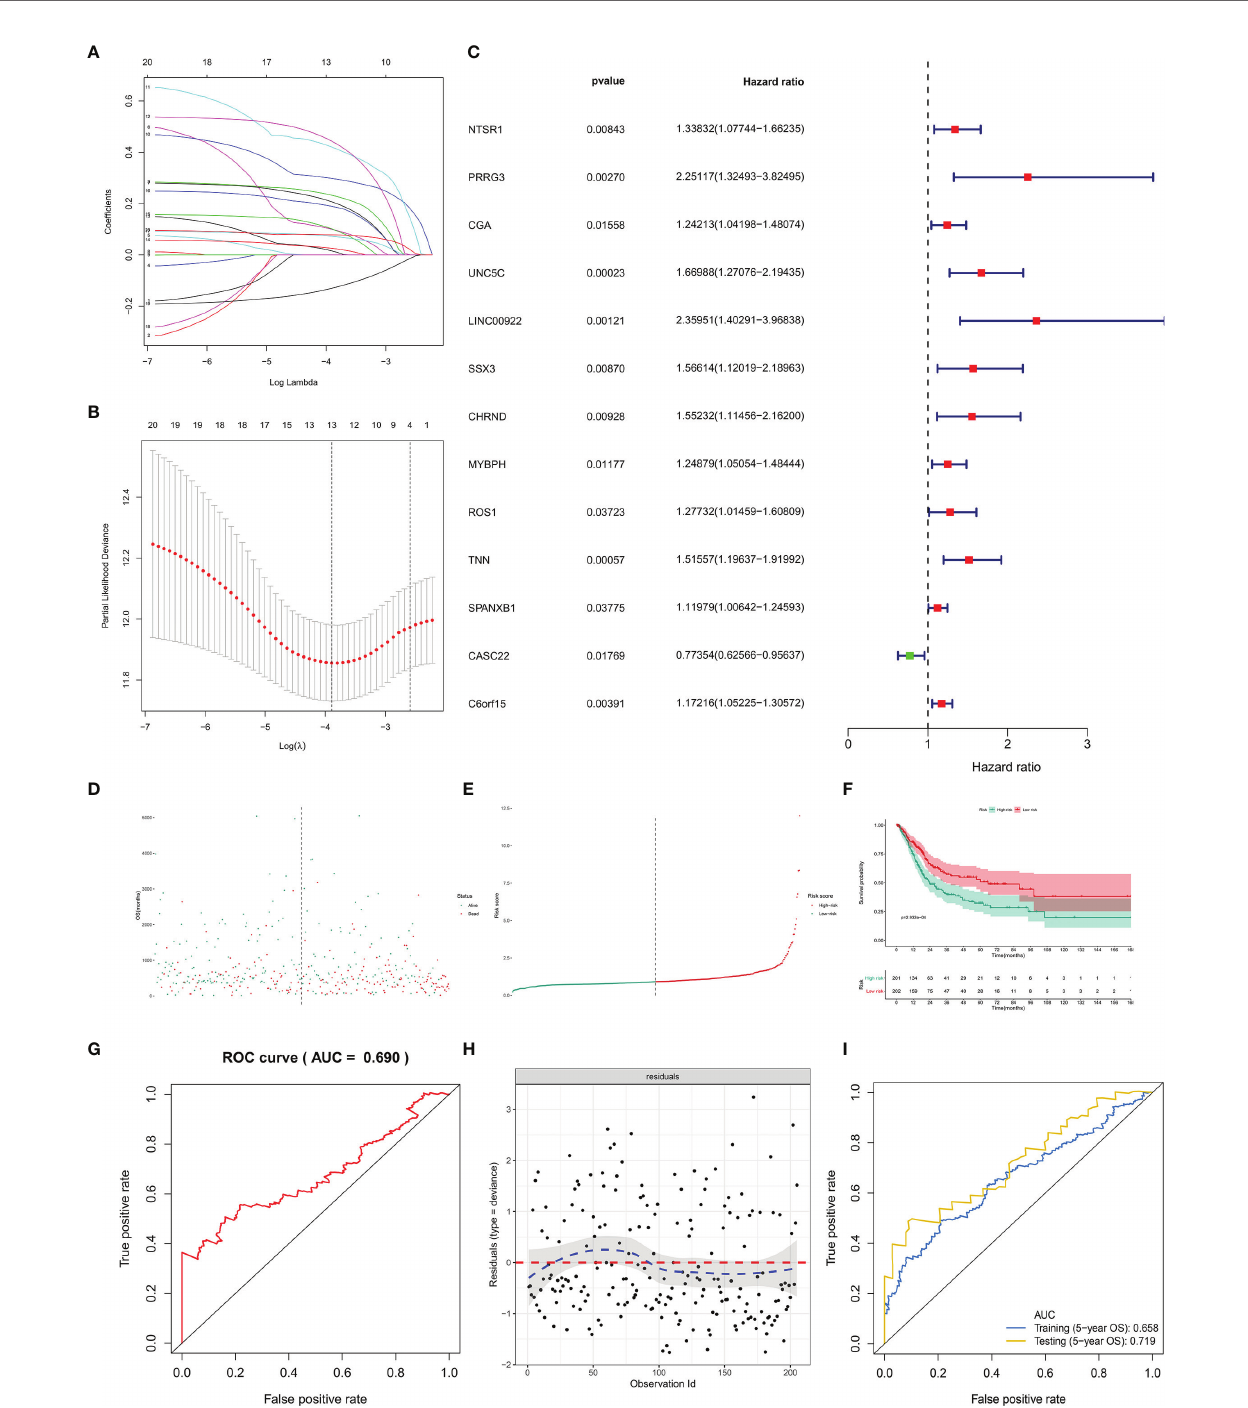
FIGURE 7 | The model diagnosis of multivariate Cox model including prognostic stemness-related genes. (A) The fi nal multivariate model of the 20 prognostic stemness-related genes. (B – E) The LASSO regression analysis of the model. (F) The Kaplan-Meier analysis of the risk score. The ROC curve (G) and residual plot (H) of the multivariate model. (I) And the fi ve-fold cross-validation of the multivariate Cox model was performed, also showing similar discriminations to the original model (AUC of training dataset (5 − year OS) = 0.658; AUC of testing dataset (5 − year OS) =